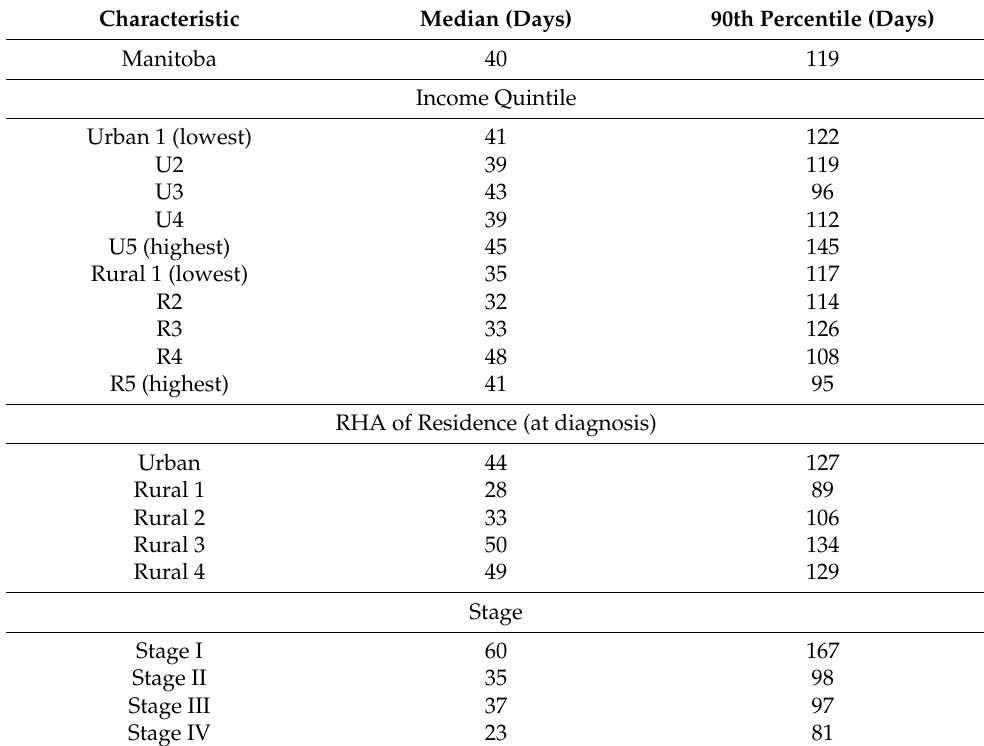
Table 4. Number of Days between First Colonoscopy and First Resection Among Colon Cancer Patients, 2010–2015.